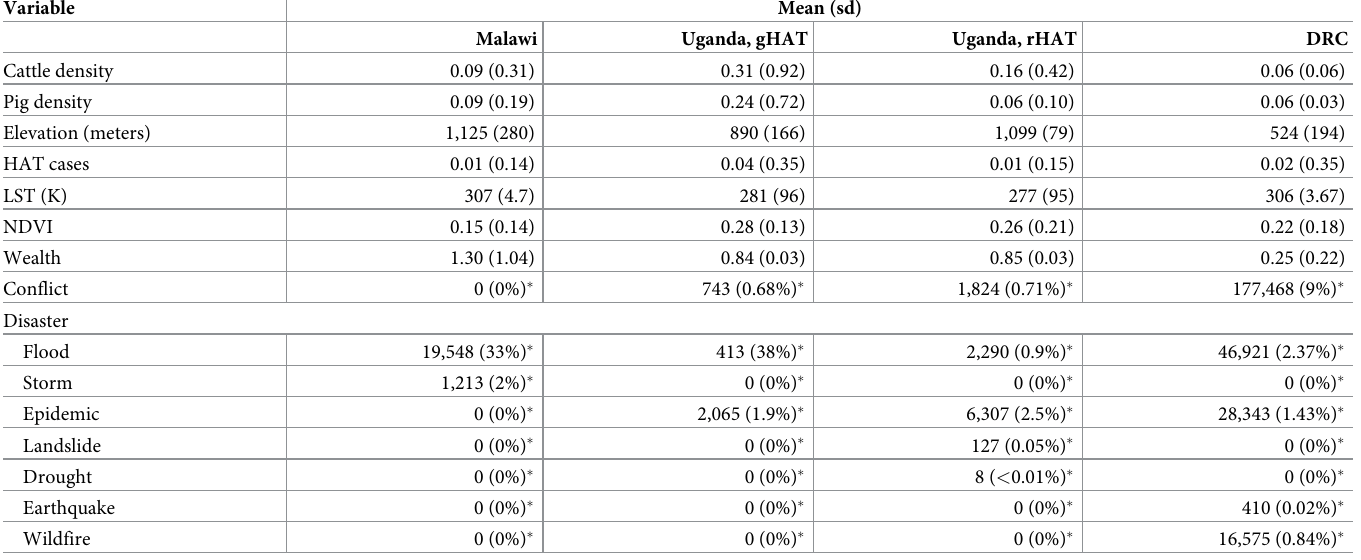
Table 1. Descriptive statistics, Malawi, Uganda, and